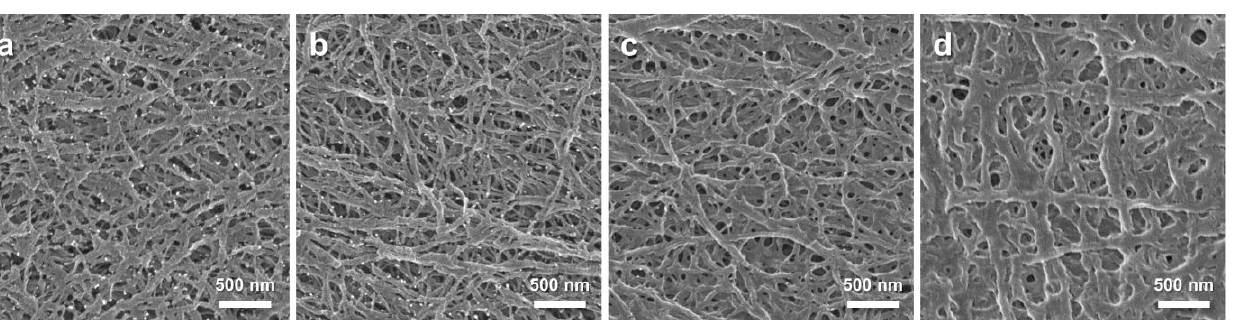
Figure 2. FE-SEM images of the ( a ) PE, ( b ) PE-TA, ( c ) PEEK@TA-PE, and ( d ) PE separators after the PEEK coating five times.